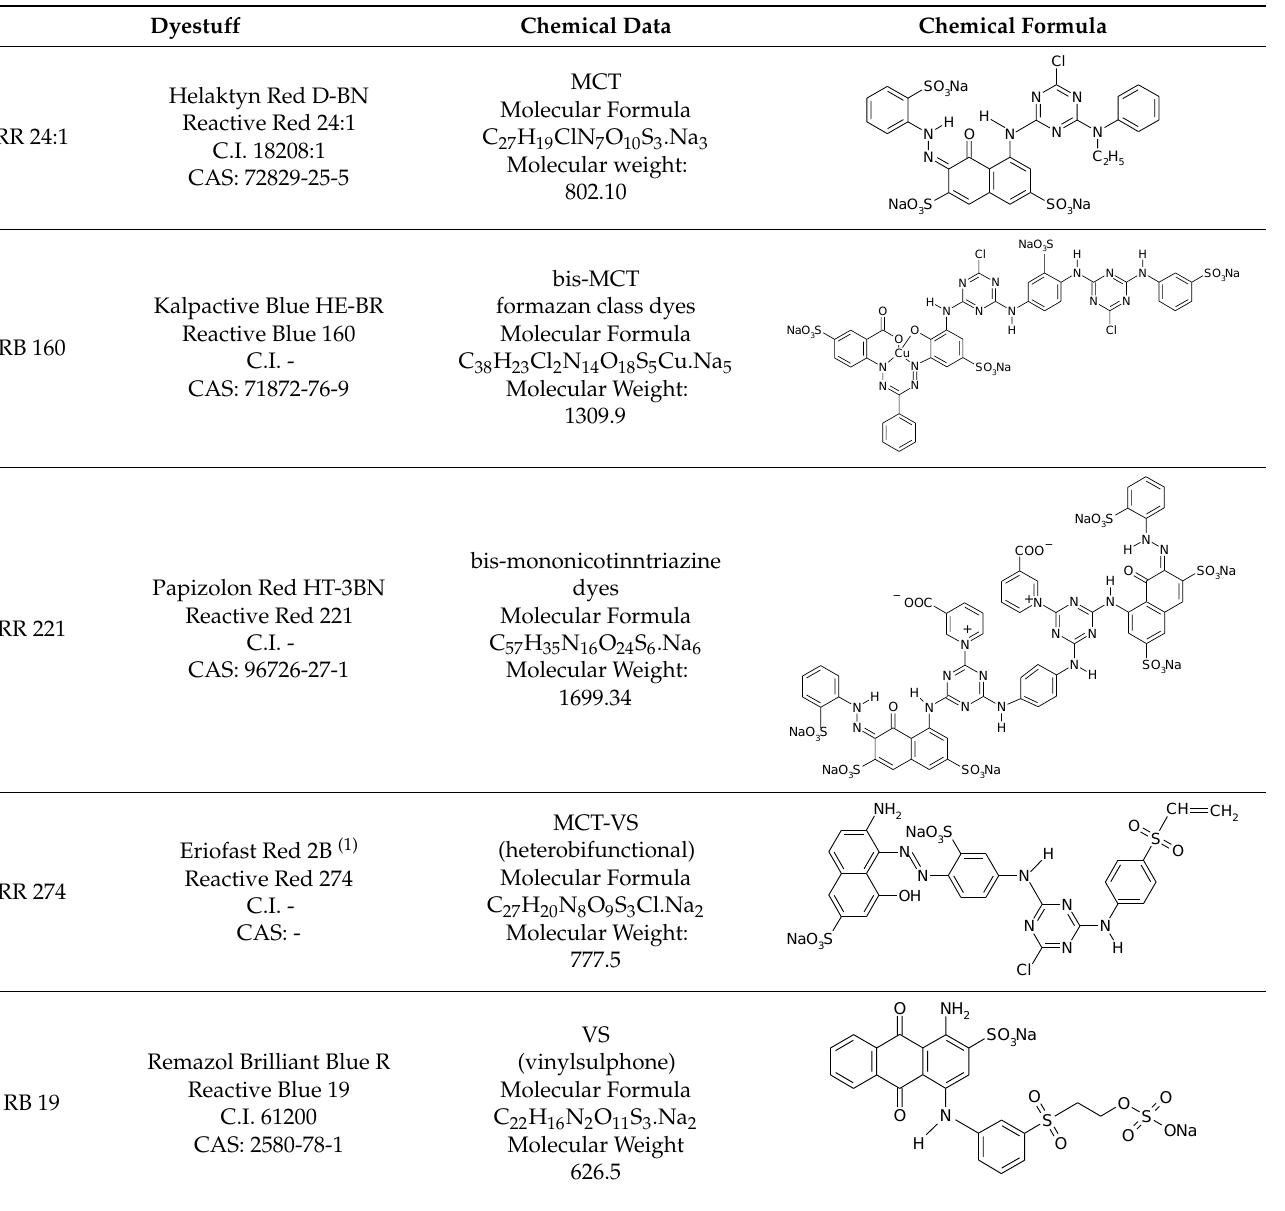
Table 2. Information data of the dyes selected for experiments.